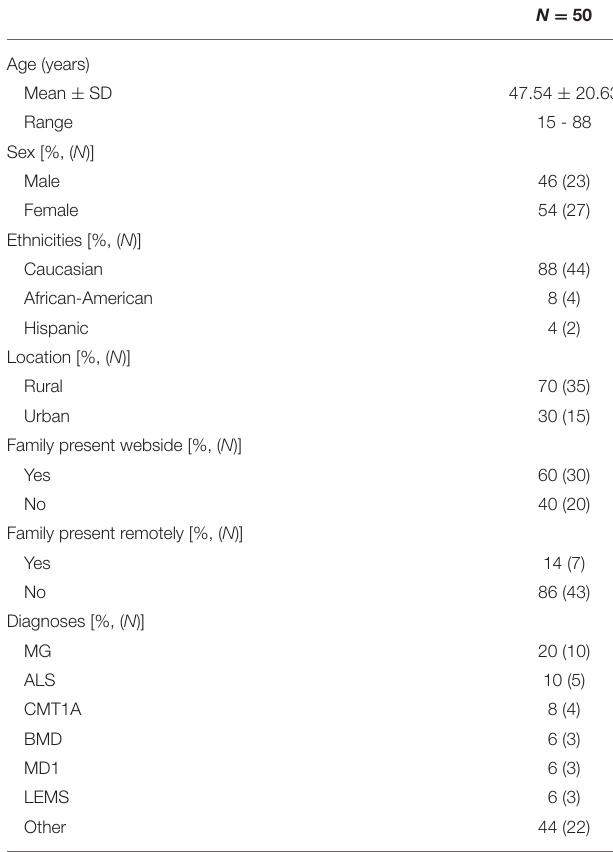
TABLE 1 | Demographic data of neuromuscular disease